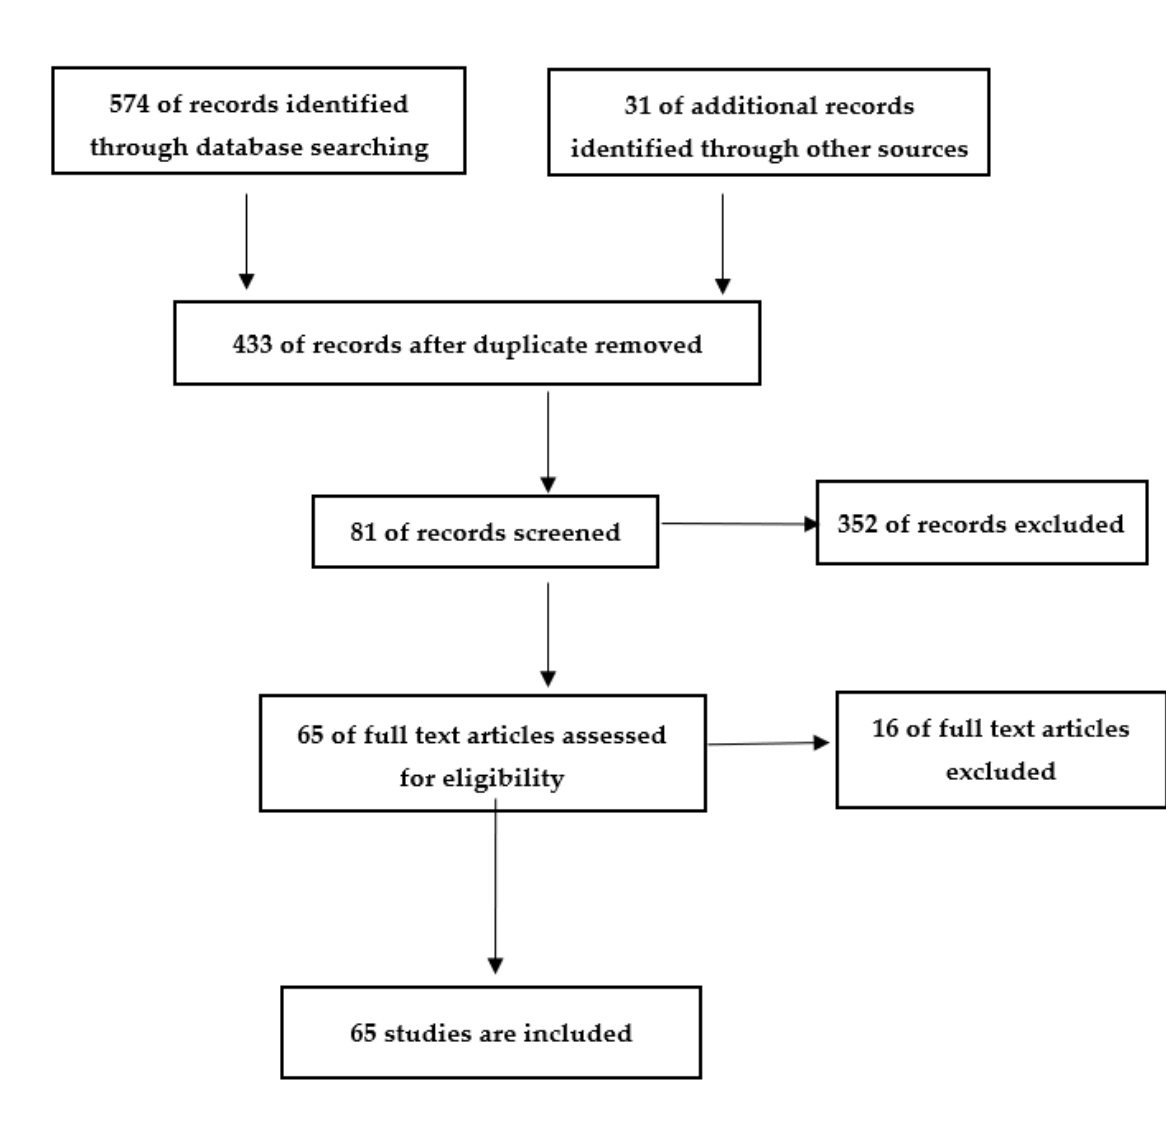
Figure 1. PRISMA flow diagram.